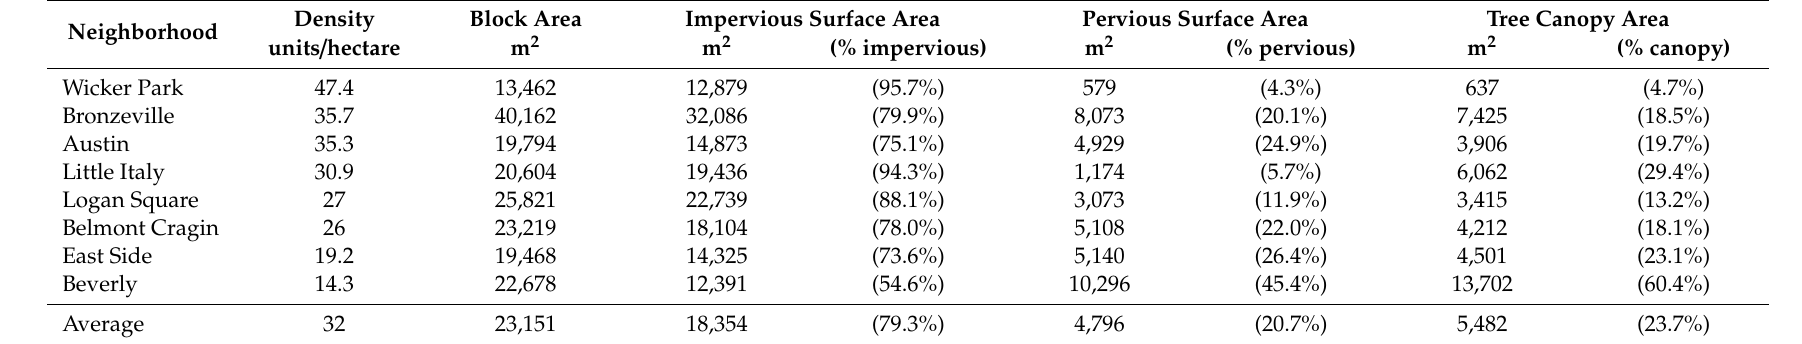
Table 5. Descriptive statistics of three-dimensional characterization of land cover in 2010 for eight Chicago